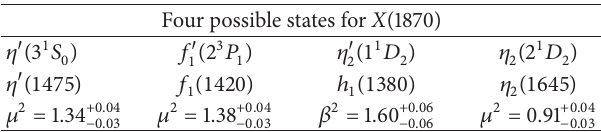
Table 3: 𝑋(1870) calculated in RTs for different states. The masses of 𝜂 󸀠 (1475) , 𝑓 1 (1420) , ℎ 1 (1380) , and 𝜂 2 (1645) are taken from PDG